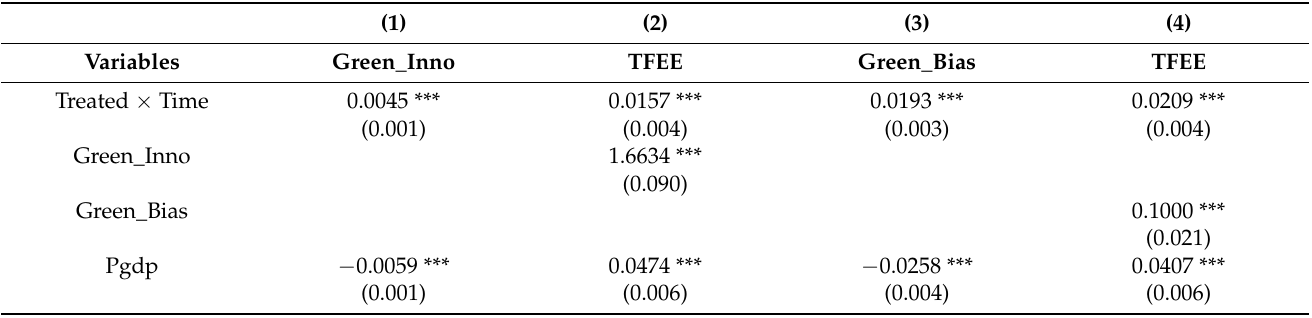
Table 10. Mediating effect test: green technology innovation and green technology